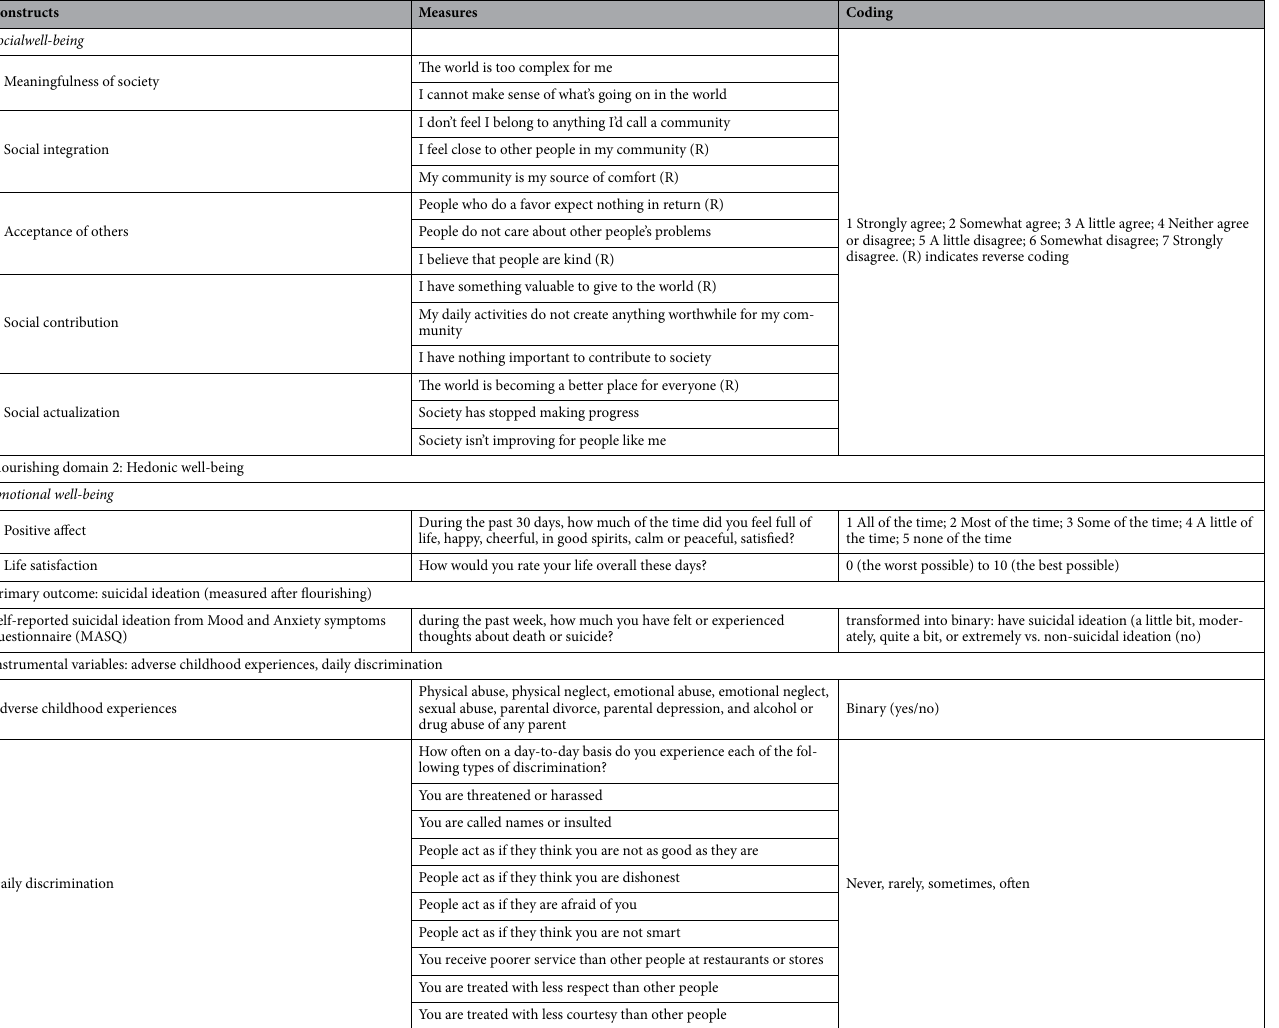
Table 1. Measures of primary exposure (Flourishing Subscales and Domains), primary outcome and instrumental variables. We used two algorithms to measure flourishing based on the theory. (1) Binary Scoring Algorithm: For each of the 13 scales above (6 psychological + 5 social wellbeing + 2 emotional wellbeing), we computed binary measures, where cut-points were applied to code the upper third of the distribution of each summed scale as one and the lower two-thirds as zero. Flourishing was then indicated when six of the 11 psychological and social well-being scales were equal to one, and at least one of the two emotional well- being scales was equal to one. A second binary measure was constructed in the same way, but omitted the 2 emotional well-being scales such that the measure was equal to one when six of the 11 psychological and social well-being scales were equal to one and zero otherwise. (2) Z -score Scoring Algorithm: All 13 scales are summed and converted to a z -score. A second measure also summed the measure, but omitted the 2 emotional well-being items, and was then converted to a z -score. Flourishing was measured temporally prior to suicidal